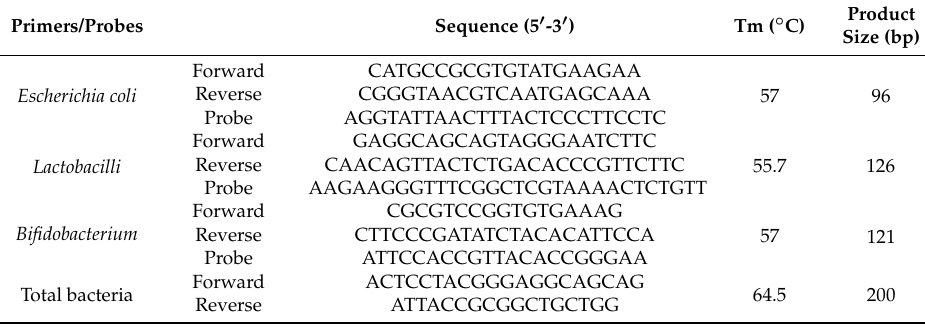
Table 2. Oligonucleotide primers and probes used for bacteriological analysis.